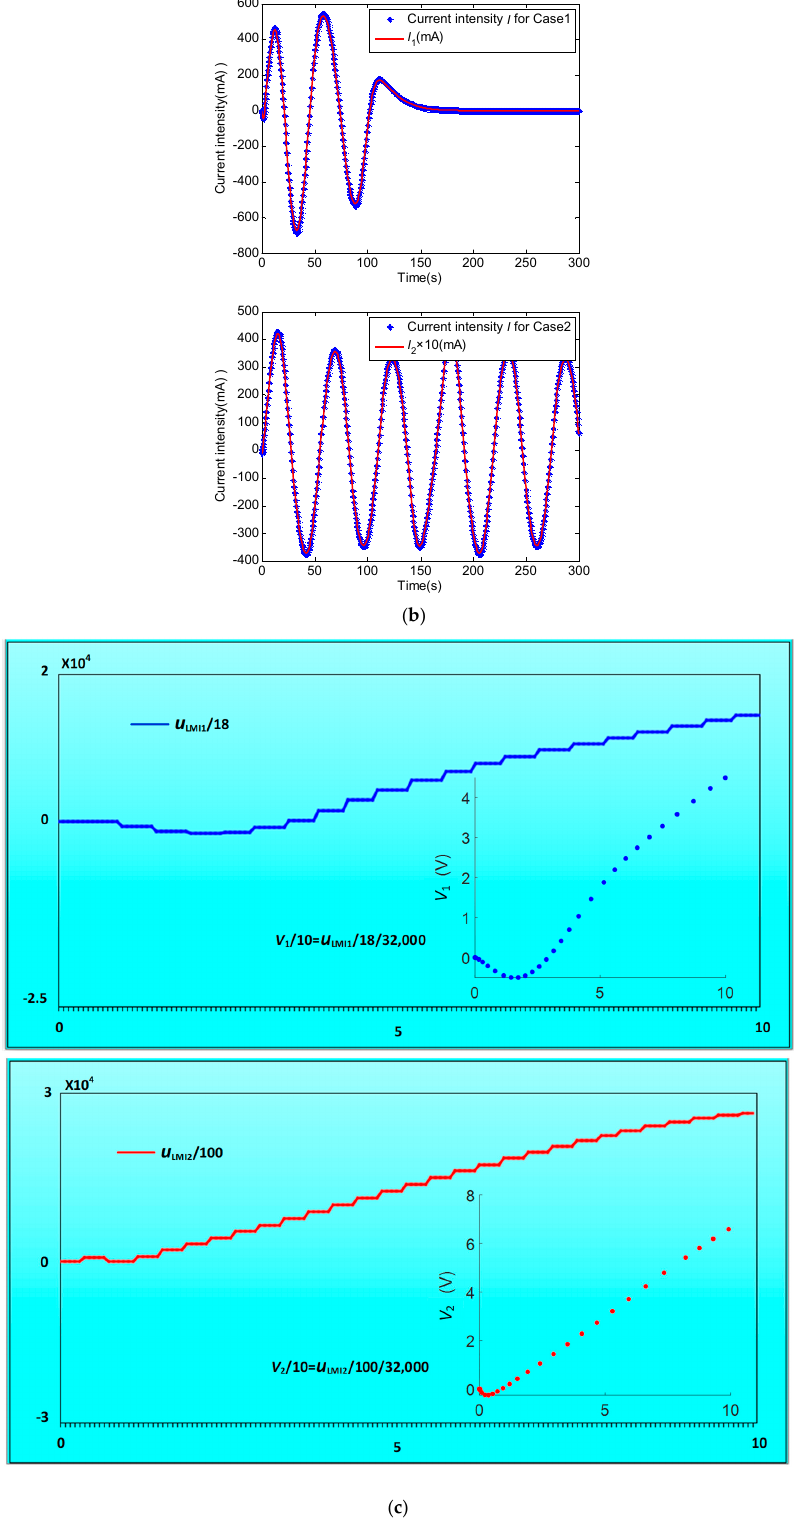
Figure 6. The experimental results: ( a ) the output characteristic curve of EM232; ( b ) comparisons between the theoretical current signals from simulation and the actual current signals processed by hardware configuration in two di ff erent cases of PFV valves; ( c ) the dynamic-signal fluctuations of digital quantity and output voltage signals displayed in